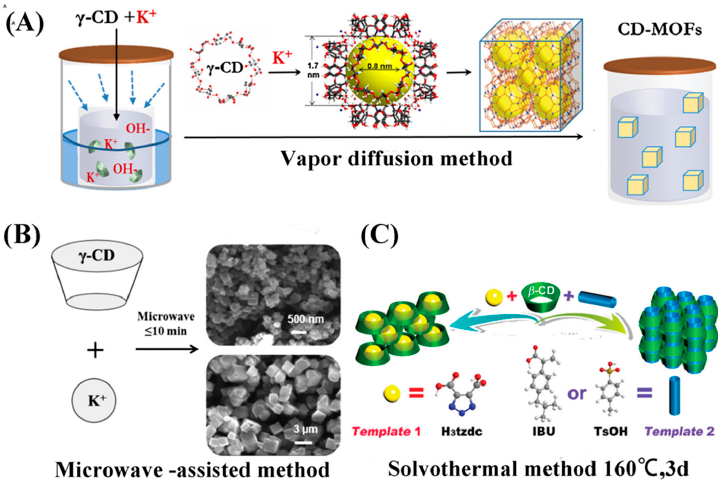
Figure 2. The three synthetic routes of CD-MOFs. ( A ) the schematic representation of γ -CD-MOF synthesis by vapor diffusion method, ( B ) the different sizes of γ -CD-MOF were adjusted under the microwave method, ( C ) the schematic view of different structural formation of CD-MOF by using different templates in the reaction process. Reprinted with permission from [63,78,80], copyright RSC, 2017; ACS, 2017; and Elsevier, 2017.